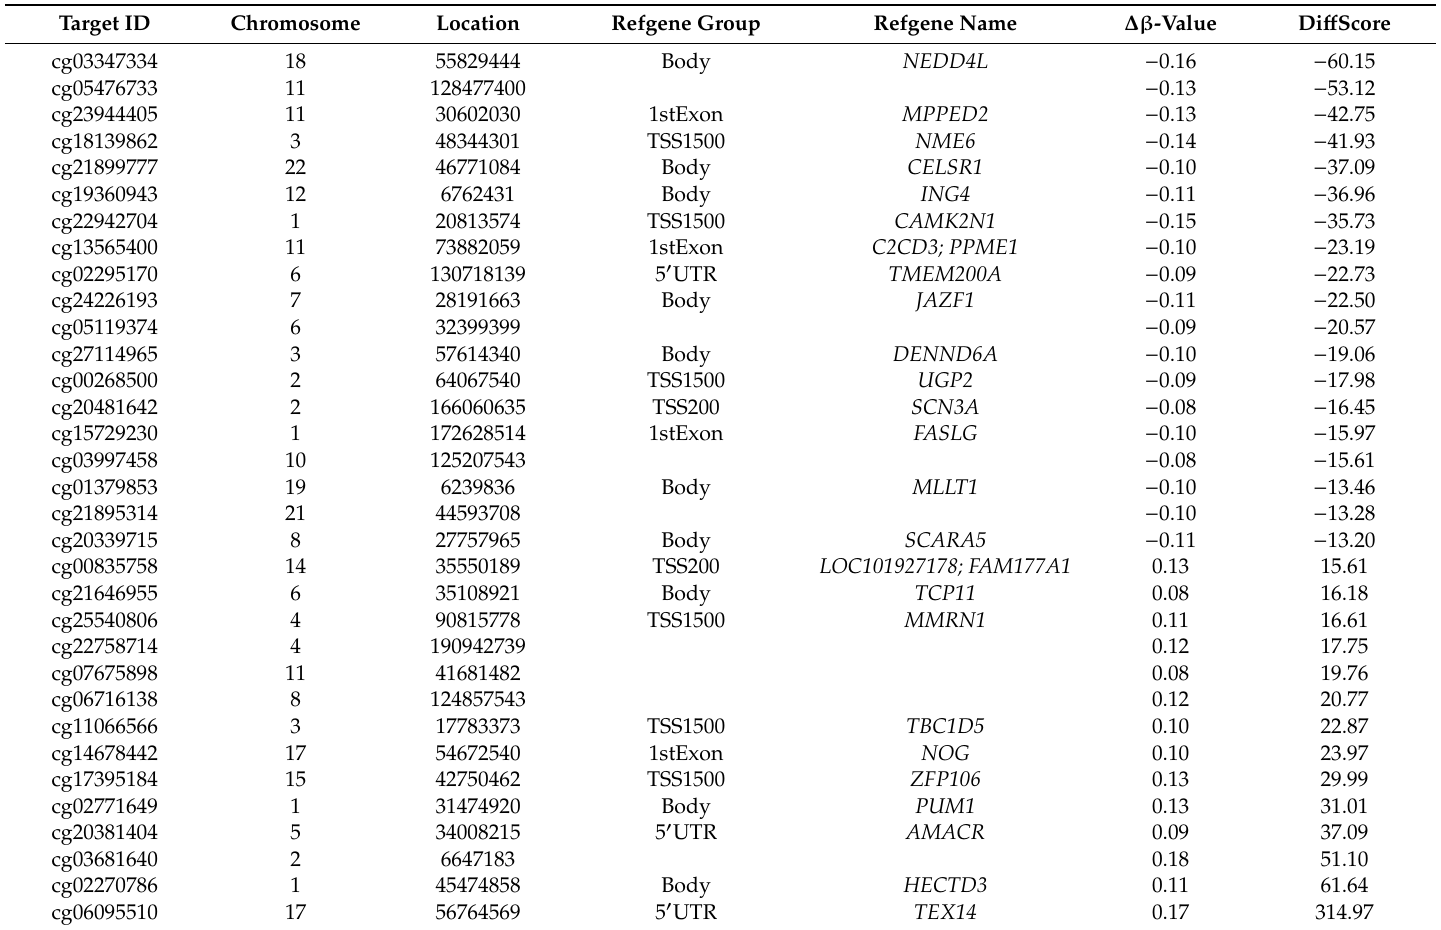
Table 2. Detailed presentation of targets a ff ected by acute exercise. Genomic location of targets is given by the chromosome and location, as well as its orientation to the gene (refgene group). If a gene is annotated to the target cytosine guanine dinucleotide (CpG), the refgene name is presented. The di ff erence in DNA-methylation for each target is shown as ∆ β -value and the corresponding Di ff Score given. The Di ff Score is a transformation of the p -value and indicates di ff erences between both time points. A Di ff Score of ≥ | 13 | represents a p ≤ 0.05. Presented is the false discovery rate corrected Di ff